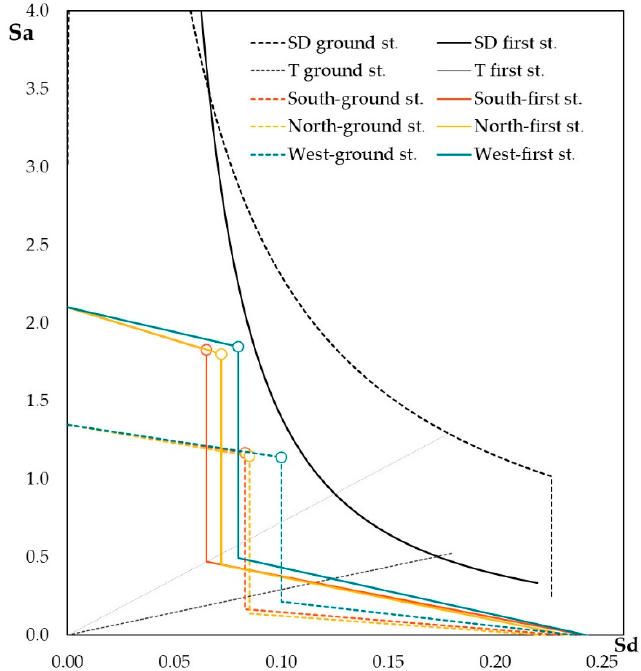
Figure 16. Capacity curves of local mechanisms with tie rods and demand spectra at ground and first floors (empty dots represent the displacement capacity at SD limit state; radial lines indicate the structure’s period T at displacement capacity).